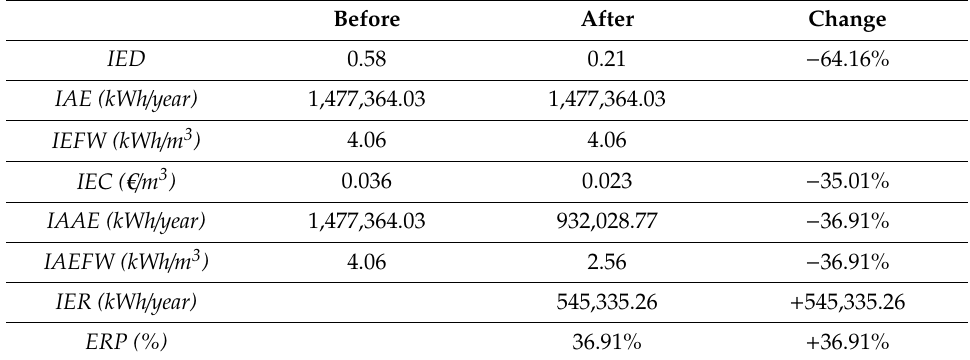
Table 18. Sustainability indicators for point #7